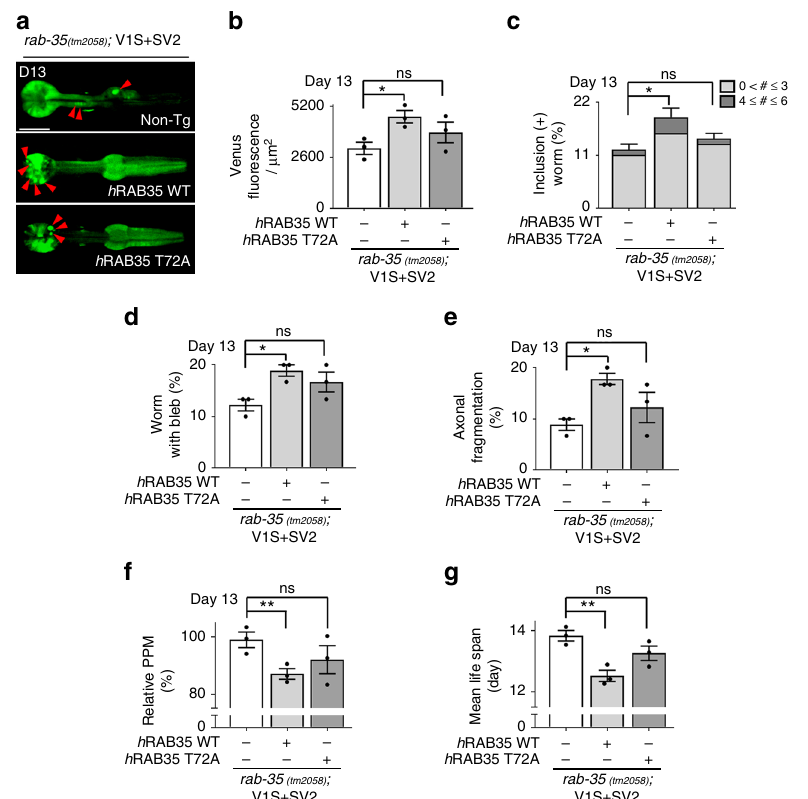
Fig. 6 RAB35 Phosphorylation is necessary for regulation of α -synuclein propagation. a Venus BiFC fl uorescence in Non-Transgenic (Non-Tg), h RAB35 WT, and h RAB35 T72A transgenic line at day 13. The red arrowheads indicate Venus BiFC-positive inclusions in pharynx. Scale bars: 200 μ m. b Quanti fi cation of Venus BiFC fl uorescence at day 13. Thirty worms for each line were used ( N = 3 in each group). F(2, 6) = 4.105, ns: not signi fi cant, * p < 0.05. c Worms with Venus BiFC-positive inclusions at day 13. The color bars in graph ( c ) show percentages of worms that have Venus BiFC-positive inclusions in rab-35 (tm2058) BiFC transgenic background. Thirty worms for each line were used ( N = 3 in each group). F(2, 6) = 4.670, ns: not signi fi cant, * p < 0.05. d, e Quanti fi cation of axonal bleb number ( d ) and fragmentation ( e ) at day 13. Thirty worms for each line were used ( N = 3 in each group). F(2, 6) = 5.607 ( d ), F(2, 6) = 5.450 ( e ), ns: not signi fi cant, * p < 0.05. f Relative pharyngeal pumping rates at day 13. Thirty worms for each line were used ( N = 3 in each group). F(2, 180) = 4.421, ns: not signi fi cant, ** p < 0.01. g Mean life span ( N = 3 in each group). One hundred worms for each line were used ( N = 3 in each group). F(2, 6) = 10.750, ns: not signi fi cant, ** p < 0.01. All values shown in fi gures are represented as mean ± SEM. P values, including ns: not signi fi cant, * p < 0.05, ** p < 0.01, were calculated by one-way ANOVA with Dunnet ’ s post hoc